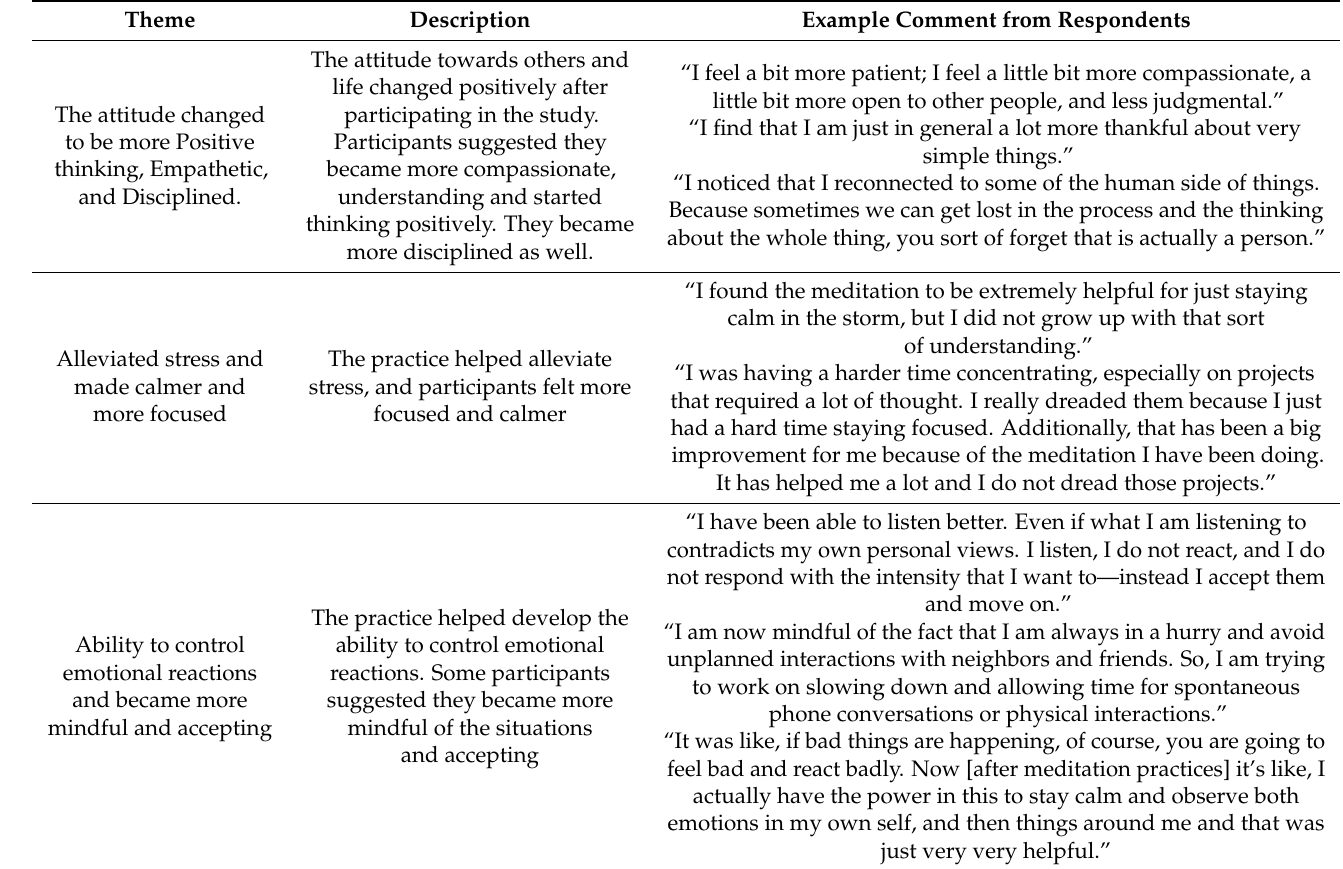
Table 3. Emerging themes on the impact of the Heartfulness meditation